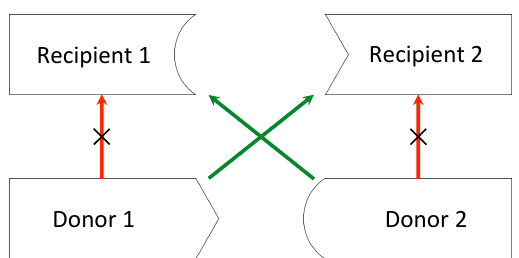
Figure 1. Pairwise exchange. Donor 1 and donor 2 are both incompatible with their intended recipients. By exchanging donors, recipient 1 receives a kidney from donor 2, while recipient 2 receives a kidney from donor 1.